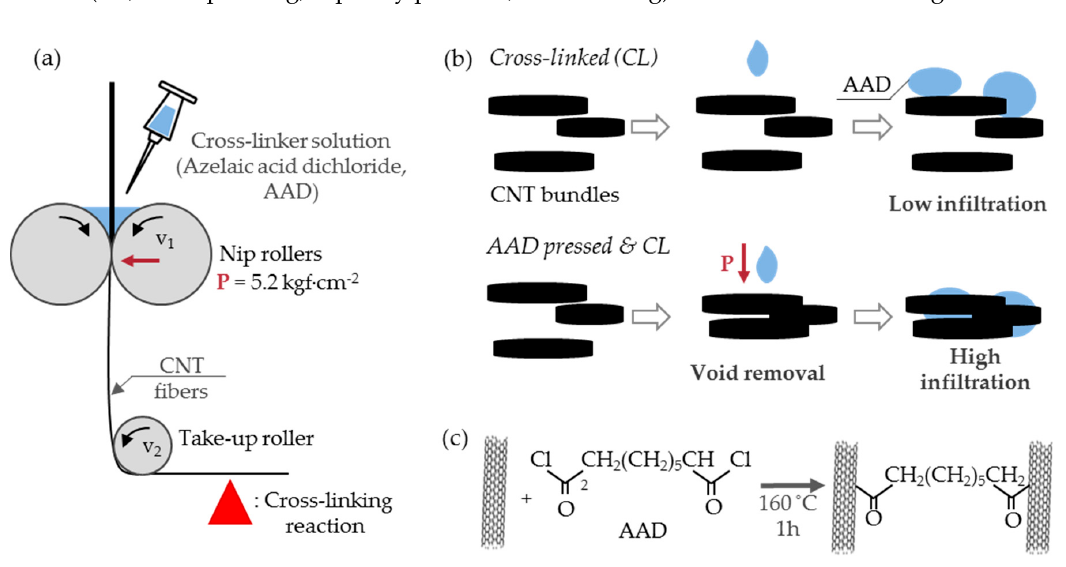
Figure 1. The schematic diagrams of ( a ) experimental procedure, ( b ) effect of roller pressing on solvent infiltration: (up) no pressing, and (down) while pressing; and ( c ) cross-linking